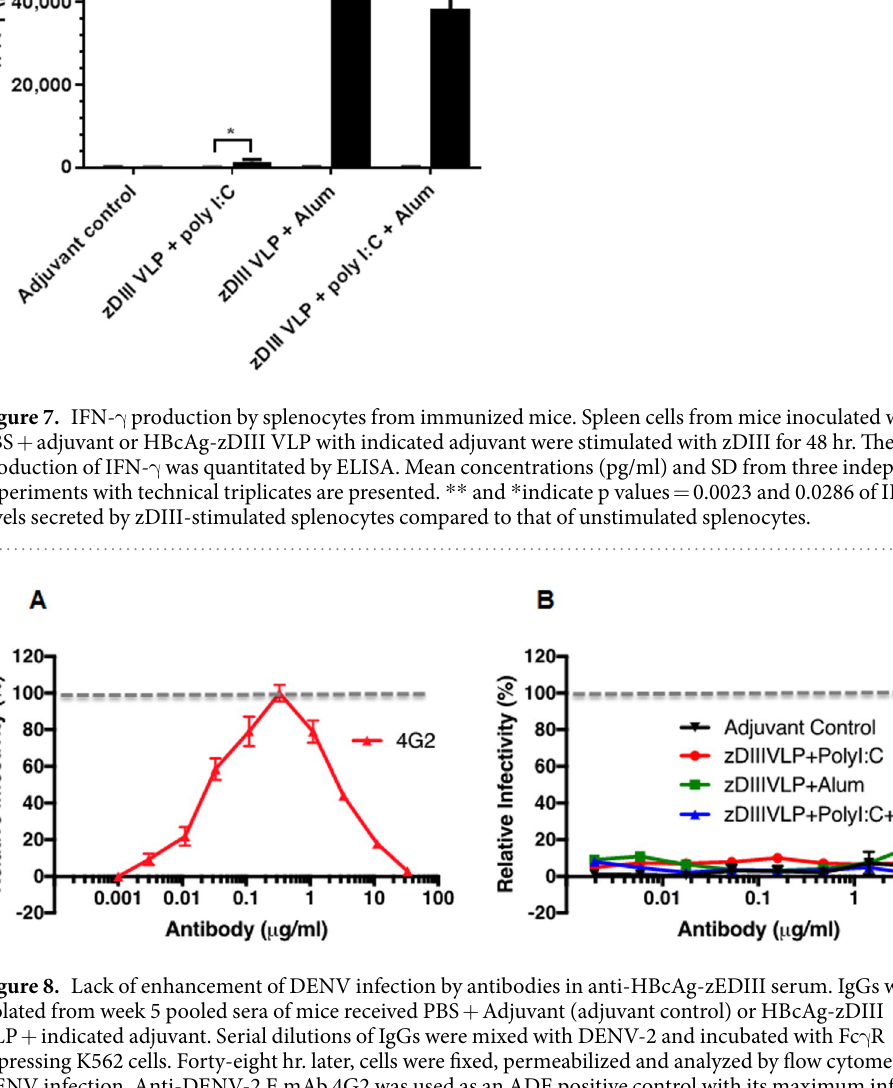
appealing vaccine candidate. In this study, we explored the possibility of producing zDIII in the form of a VLP and characterized its immunogenicity and safety in mice. We also tested the ability of plants as a production plat- form for zDIII VLP-based vaccines, aiming to address the scalability and cost issues. Our results revealed that HBcAg-zDIII VLPs (50 µ g, equivalent to 15 µ g zDIII antigen) with all three adjuvant combinations elicited a potent zE-specific humoral response with zDIII-specific IgG titers (log titer) and ZIKV neutralization titers being minimally > 4.2 and > 320, respectively, at week 5, significantly exceeding the threshold of zE-specific ( > 2.35–3.2) and neutralizing antibody titers ( > 10) required for protection against various ZIKV strains in the mouse model. Combined with the findings that (1) the majority of epitopes that induce protective immunity against flavivirus are localized on EDIII 21, 22 and (2) mice were effectively protected in lethal challenges from several strains of ZIKV by zDIII-specific antibodies 6 , our results suggest that zDIII-VLPs with poly I:C or alum as adjuvant can be as potent as the reported DNA or inactivated virus-based vaccines in evoking humoral response against ZIKV and may also provide protective immunity in mice.